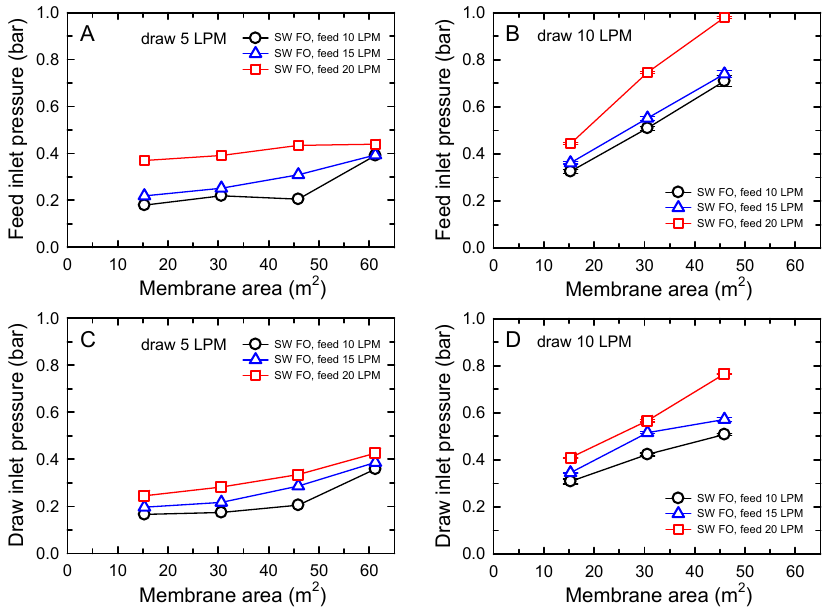
Figure A1. Inlet pressures in feed and draw channels of spiral-wound (SW) forward osmosis (FO) as a function of membrane area. The applied direct solution (DS) flow rates were 5 ( A , C ) and 10 LPM ( B , D ). The feed solution (FS) flow rates were fixed at 10 LPM. The membrane areas were adjusted via 1–4 elements serial connection of SW FO. The concentrations of FS and DS were 10 and 70 g/L, respectively.